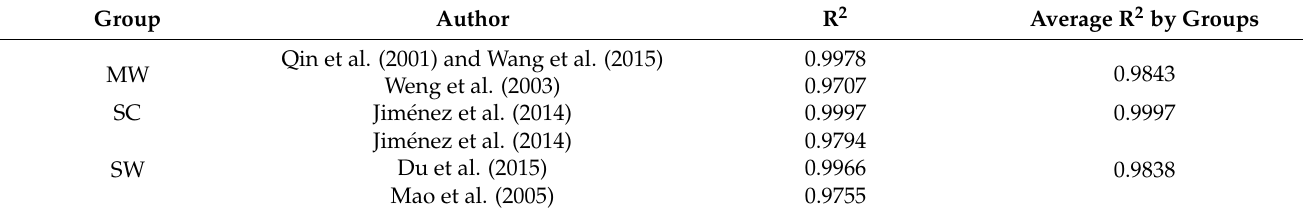
Table 9. Linear adjustment coefficients R 2 using the panel